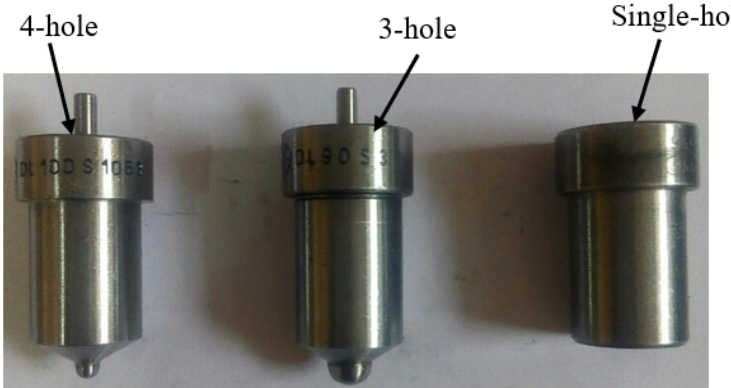
Figure 8. R180 diesel engine fuel injector assemblies.